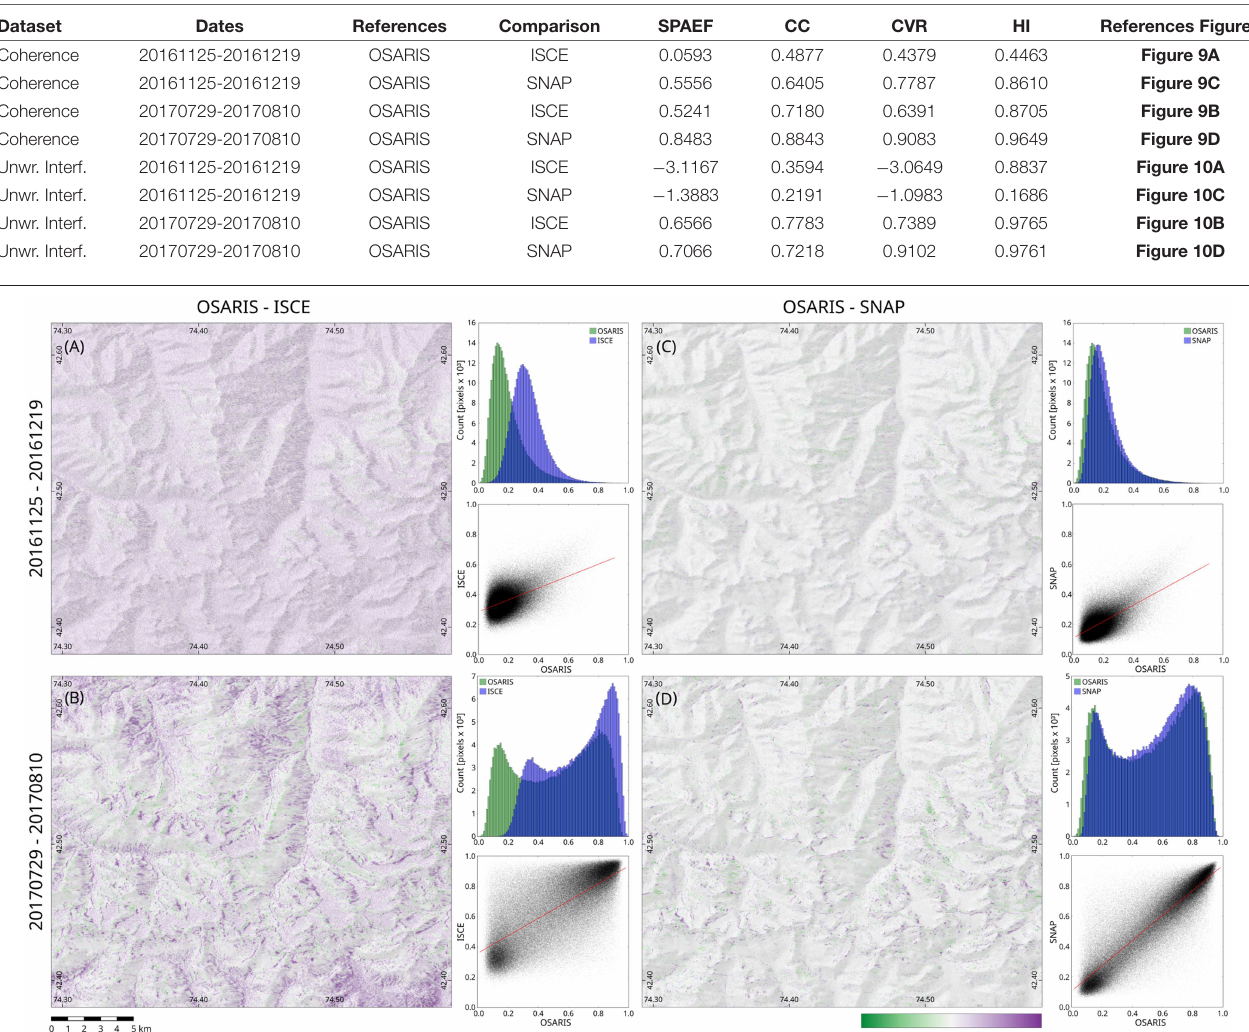
TABLE 2 | SPAtial EFficiency metric (SPAEF) results.